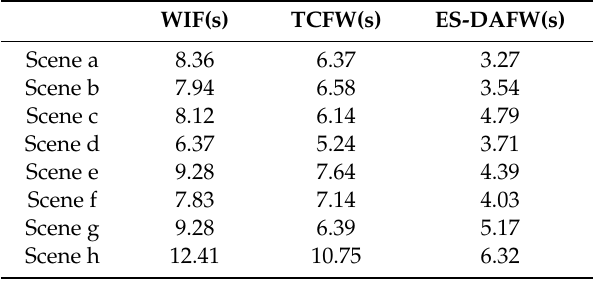
Table 8. The average times taken by di ff erent window selection methods to complete